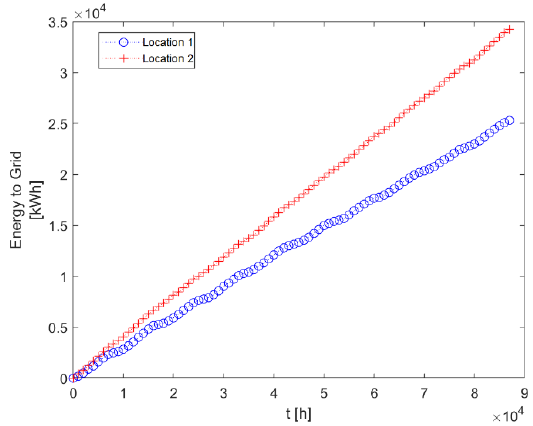
Figure 15. Energy to the grid (PV no battery).